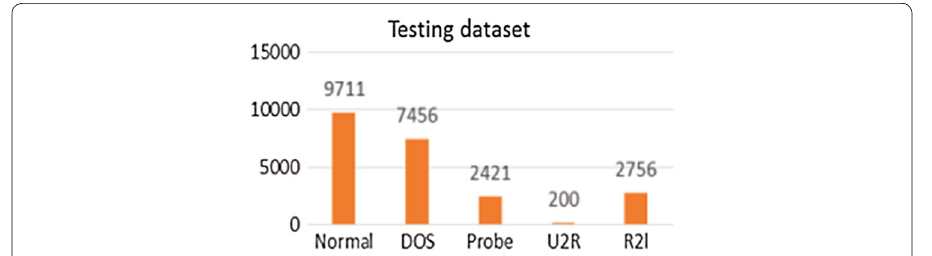
Fig. 6 Statistics about NSL-KDD testing dataset [3]. Shows Statistics about NSL-KDD training datasets. Statistics about number of samples for each type of attack